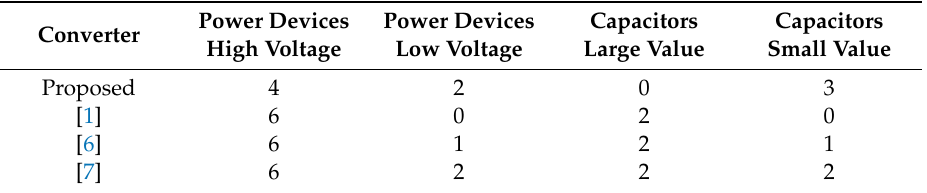
Table 2. Components